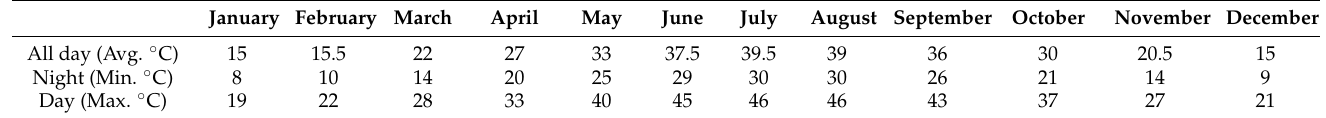
Table 1. Average daily ambient air temperature in Kuwait, adopted from